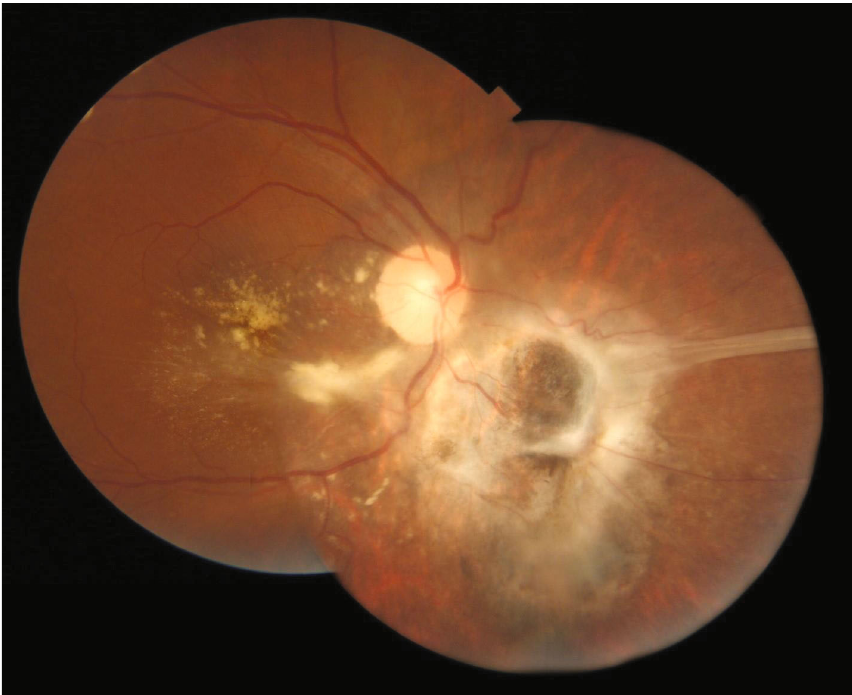
Figure 3: Montage fundus photography of the patient ’ s right eye three months after initiation of antitoxoplasmosis treatment and HAART shows complete retinal reattachment. A retinal fold extends from the lesion to the nasal periphery. Subretinal exudates are seen in the inferior area of the disc and around the